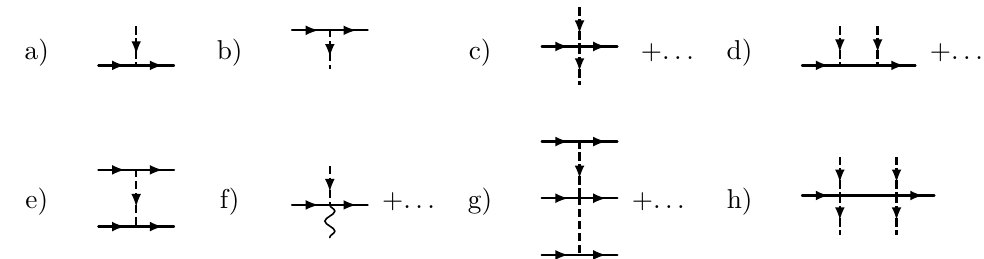
Table 2 . List of amplitudes for which the soft theorem has been checked. In particular, the list contains all tree-level amplitudes with four external legs or less. In the cases where multiple diagrams contribute, we have picked a single representative diagram. All other diagrams can be constructed by permuting external legs and splitting up internal four-point